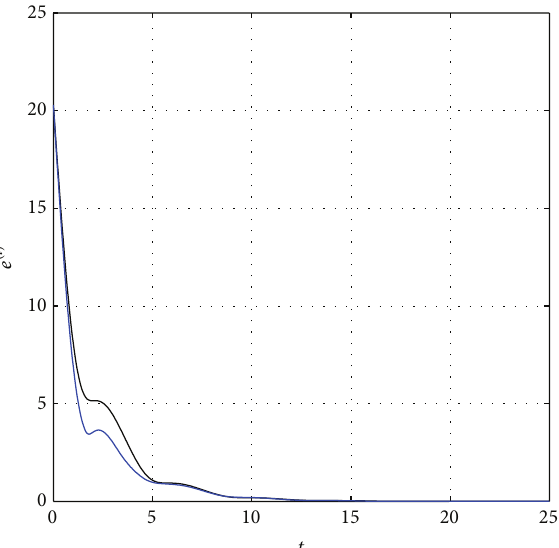
Figure 1: Digraph of 3 nodes.